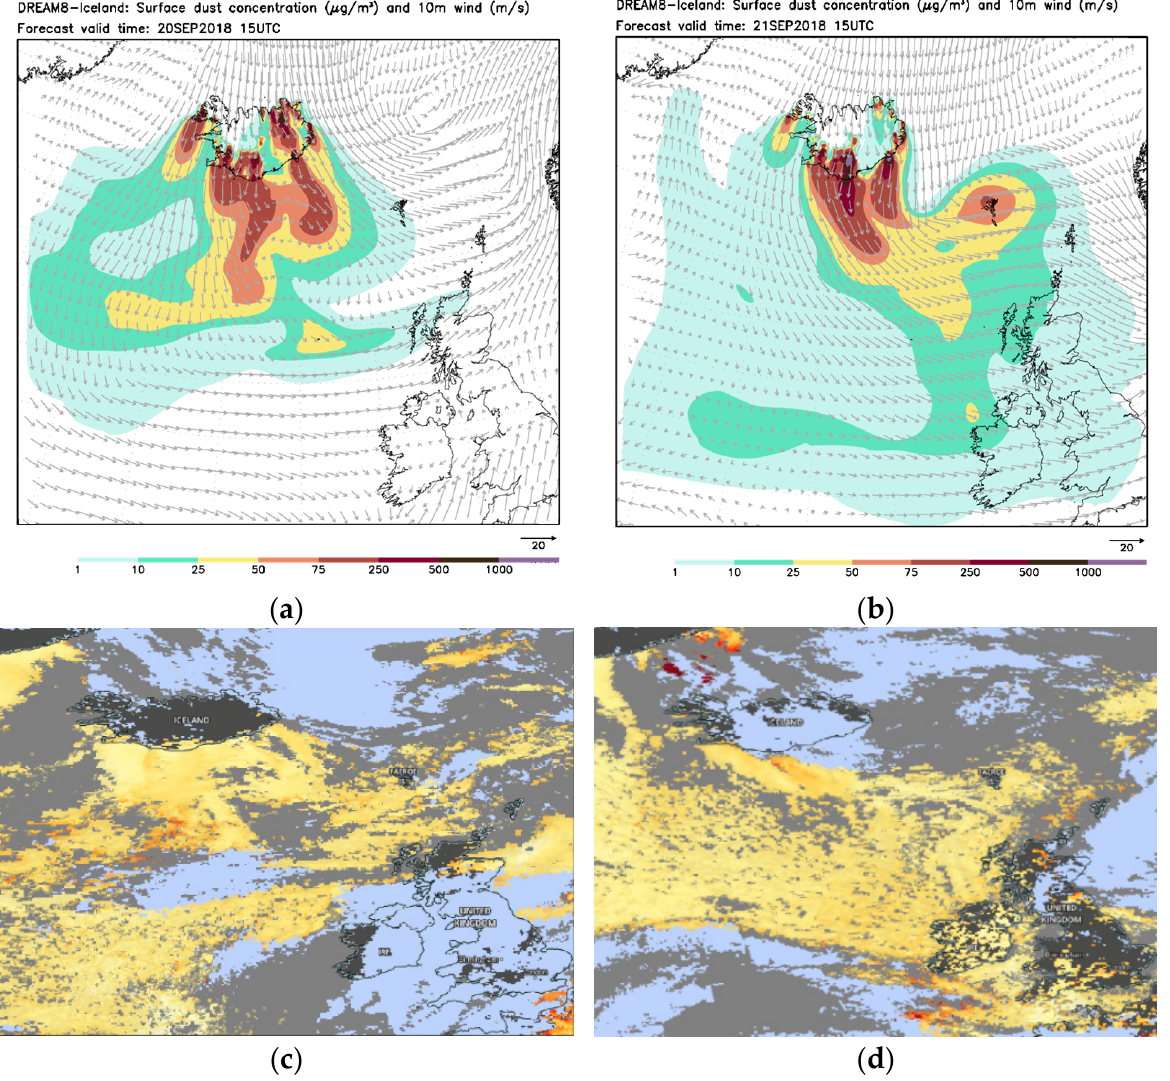
Figure 14. Dust storm 20–21 September 2018. ( a – c ) DREAM surface dust concentration; and ( c – d ) MODIS AOD.